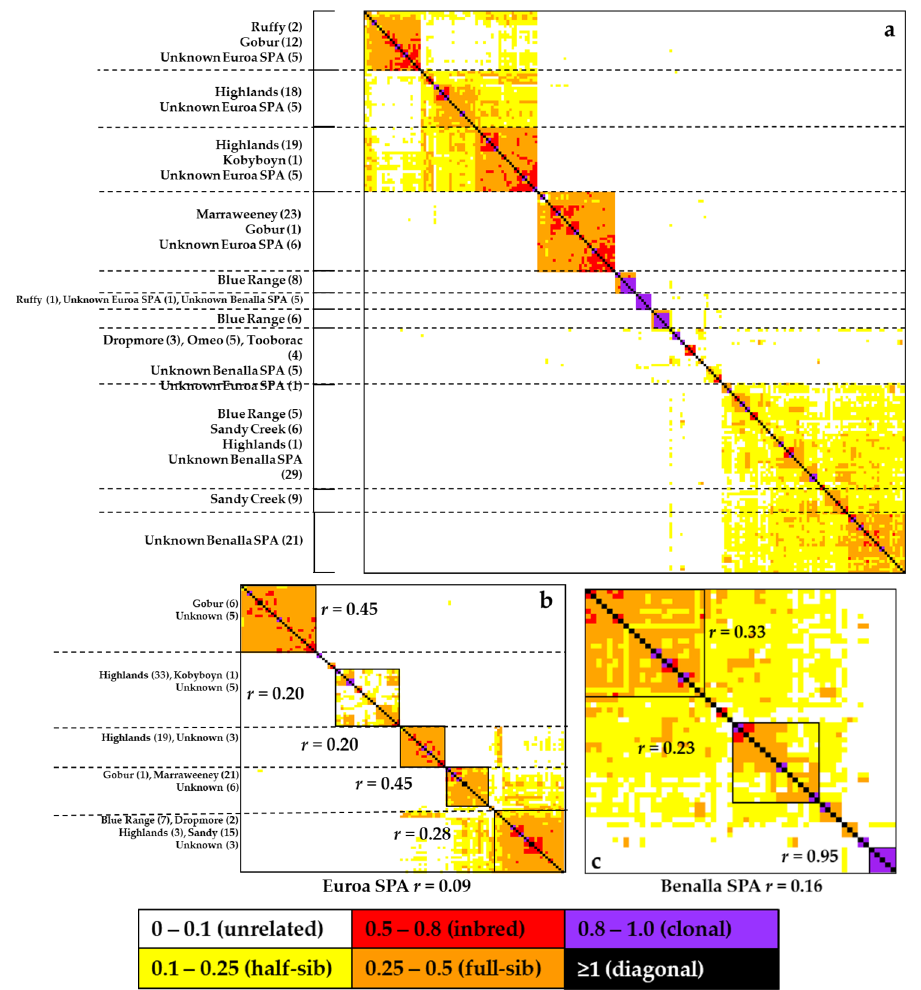
Figure 3. Genomic relationship matrix ( G ) giving pairwise relatedness ( r = 2 θ ) estimates based on pairwise comparisons using the Wang (2007) estimator for ( a ) all trees, ( b ) Euroa SPA only and ( c ) Benalla SPA only. The diagonal shows the relatedness of an individual to itself (1 + f , where f is Wright’s inbreeding coefficient). Colors other than white indicate close relatedness, with colors darker than orange showing relationships closer than half-sib (half-sibs, full-sibs, parent-offspring). A small number of individuals from Blue Range and Ruffy appear to be clonal or replications of the same tree.